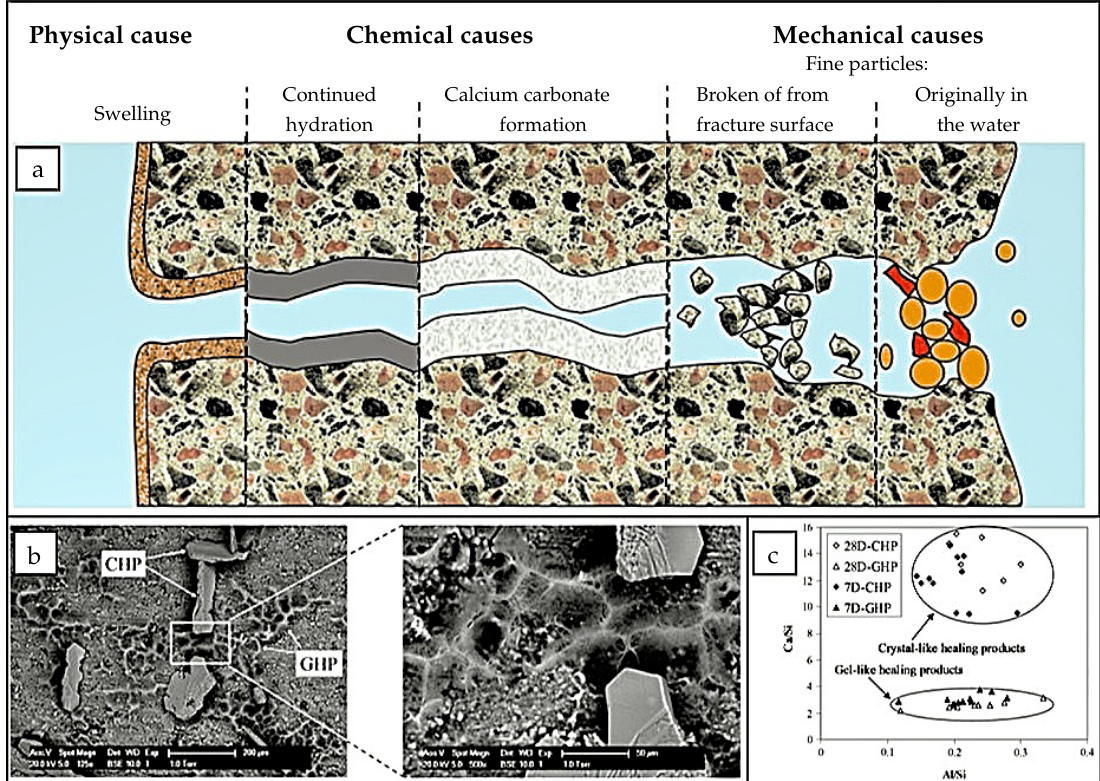
Figure 1. The autogenous self-healing mechanisms, products, and their corresponding chemical composition. ( a ) Schematic representation of the mechanisms of autogenic self-healing. Reproduced with permission from the authors of [70]. Copyright 2013, Springer. ( b ) Morphology of healing products (GHP refers to the gel-like healing product and CHP refers to the crystal-like healing product). Reproduced with permission from the authors [76]. Copyright 2013, Elsevier. ( c ) Ratios of Ca/Si and Al/Si of healing products with time. Reproduced with permission from the authors of [76]. Copyright 2013,